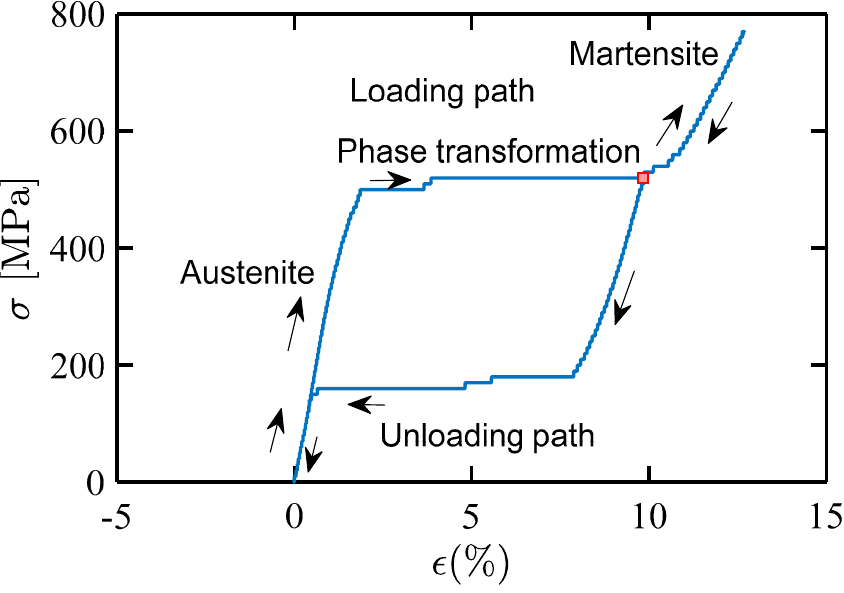
Figure 4. Stress–strain curve of individual SMA wire under quasistatic tensile loading. Figure 4. Stress-strain curve of individual SMA wire under quasistatic tensile loading. Molecules 2020 , 25 , x FOR PEER REVIEW